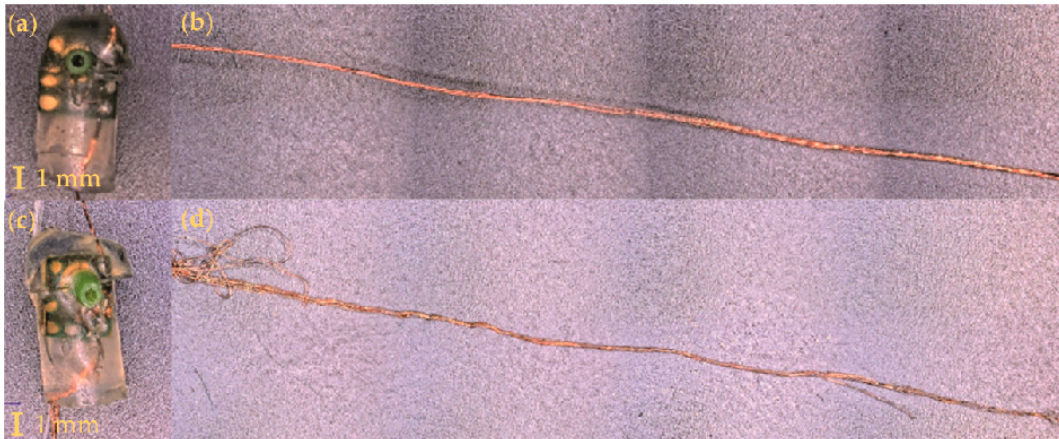
Figure 14. Microscope images of encapsulated microphones and the signal output wire of acoustic sensing yarns washed within a woven structure. Yarn C was line dried and had a final peak value of 1349 arb. Yarn D was tumble dried with a final peak value of 1338 arb. ( a ) Yarn C encapsulated microphone; ( b ) the copper wire interconnect from Yarn C; ( c ) Yarn D encapsulated microphone; ( d ) the copper wire interconnect from Yarn D.